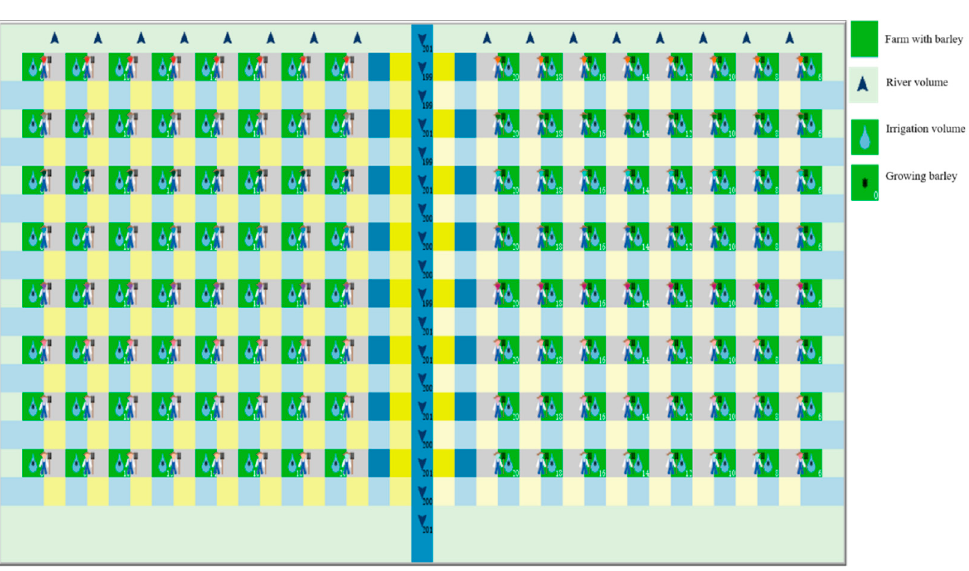
Figure A1. The model interface with running.